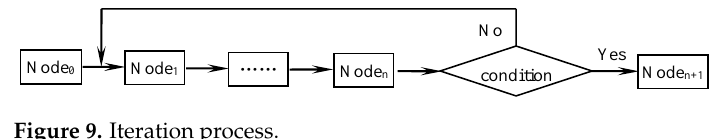
Figure 9. Iteration process.